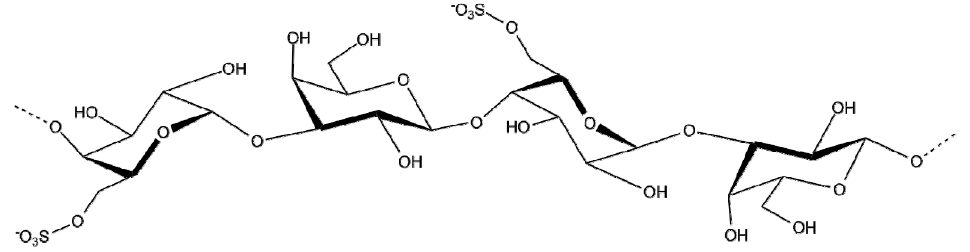
Figure 4. Idealized structure of the chemical units of porphyran.